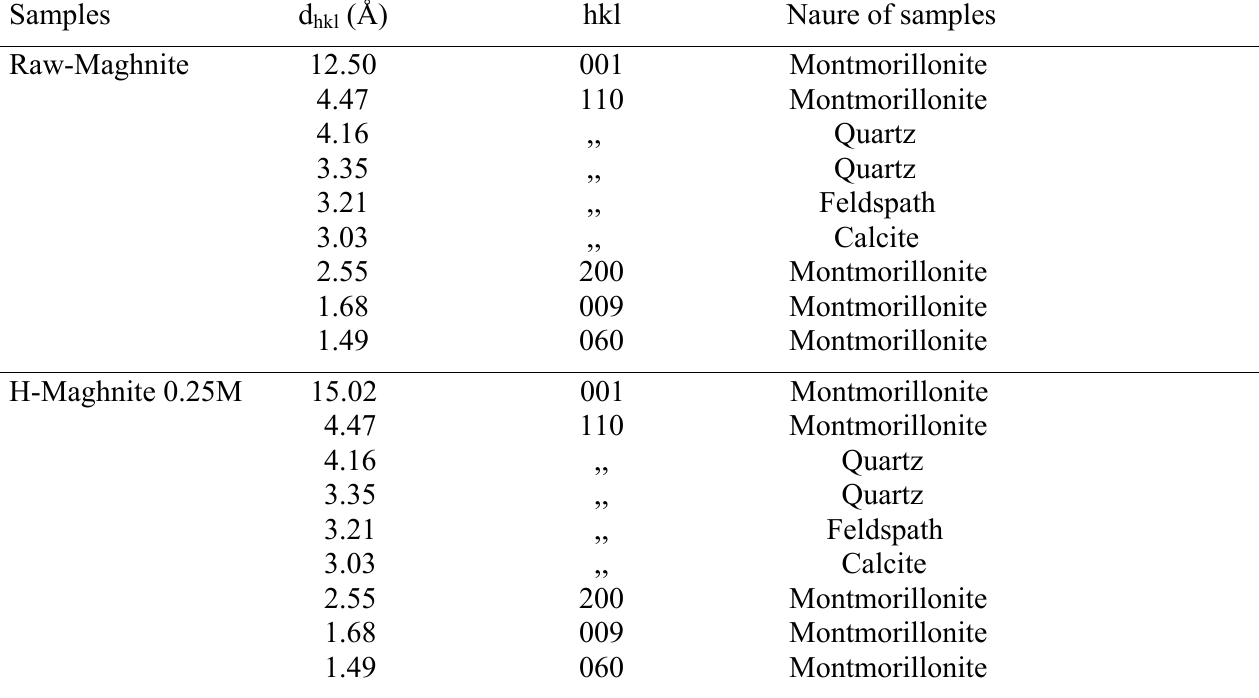
Table2. RX characteristic of Raw-Maghnite and H-Maghnite 0.25M. Samples